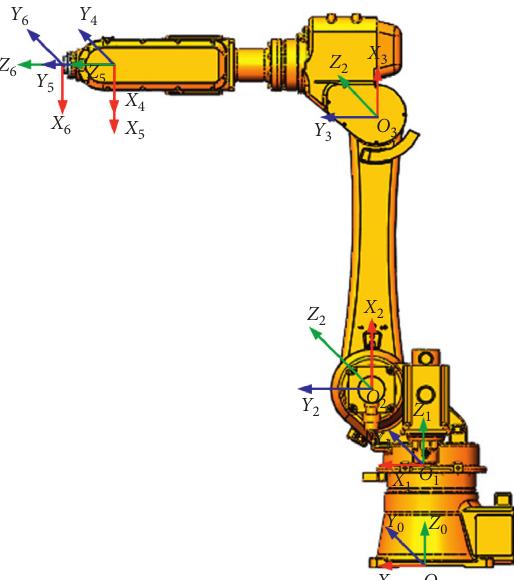
Figure 1: The kinematic model of ER20-C10 robot.